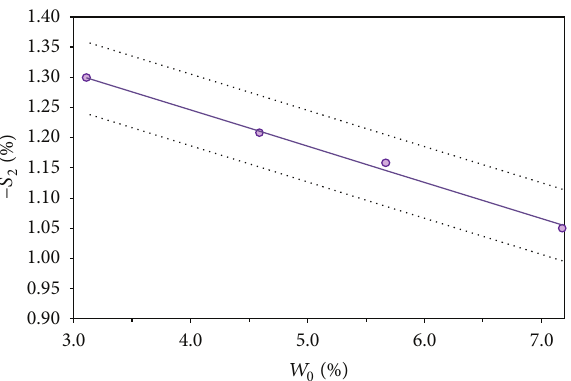
Figure 7: Springback ( 𝑆 2 ) as a function of the powder moisture content ( 𝑊 0 ) at compaction pressure ( 𝑃 1 ) of 49.03 MPa with CI 95 % (dotted lines).